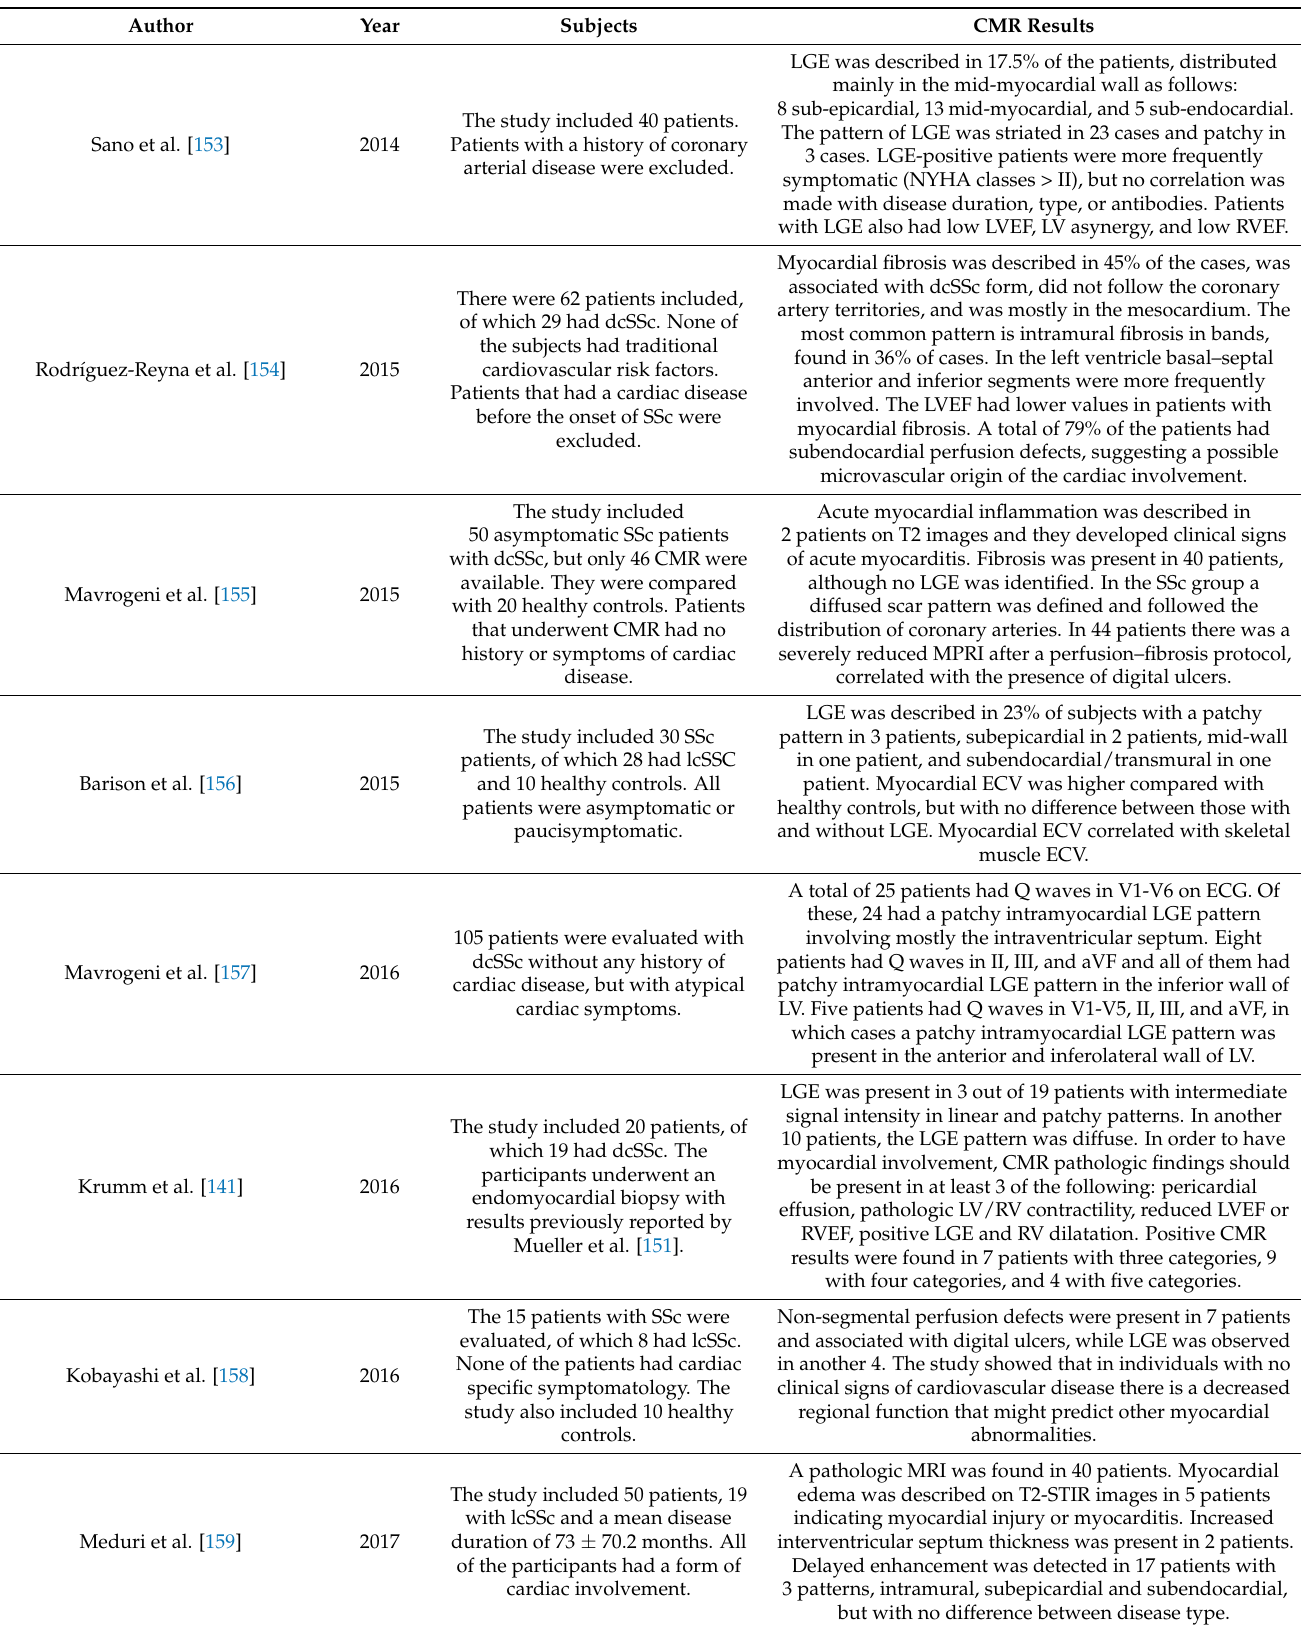
Table 7. Recent studies that used cardiac magnetic resonance to evaluate systemic sclerosis